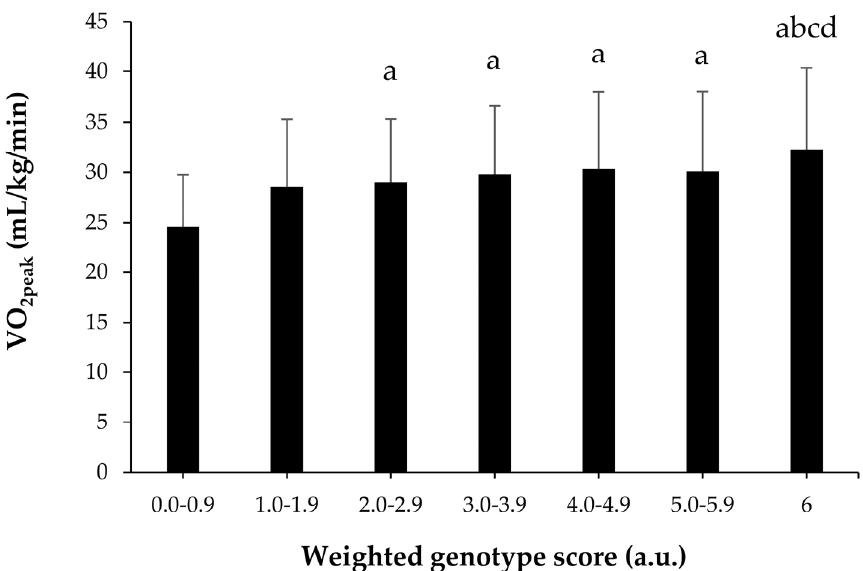
Figure 4. Peak oxygen uptake (VO 2peak ) levels in the study participants according to the genotype score (computed by using a weighted score of angiotensin-converting enzyme rs4295, angiotensin II receptor type 1 rs275652 and growth di ff erentiation factor 8 rs7570532 genotypes). Abbreviations / symbols: a.u., arbitrary units; a, di ff erence from 0–0.9 a.u. at p < 0.05; b, di ff erence from 1.0–1.9 a.u. at p < 0.05; c, di ff erence from 2.0–2.9 a.u. at p < 0.05; d, di ff erence from 3.0–3.9 a.u. at p <